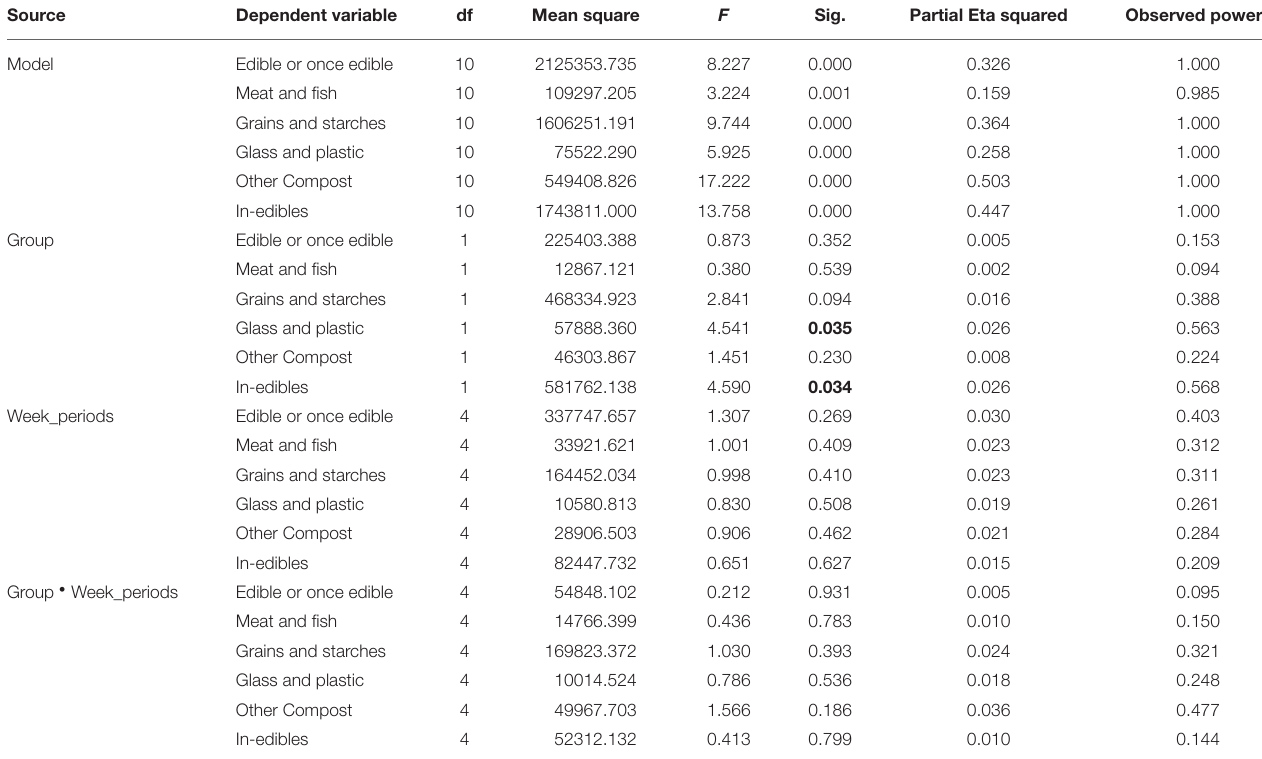
TABLE 3 | Results of the GLM multivariate analysis of variances with the six dependent variables to present main and interaction effects for each dependent variable separately.